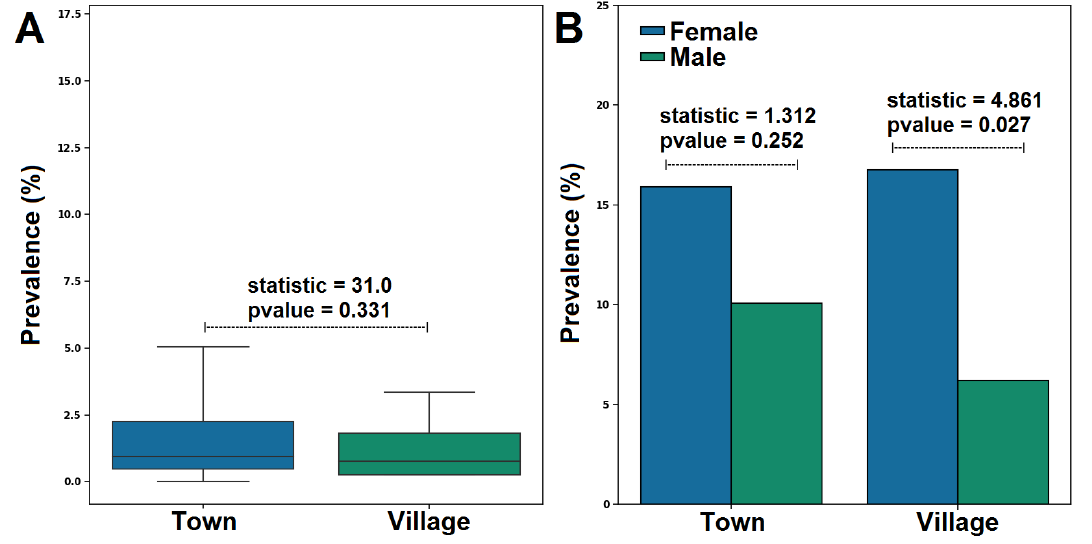
Figure 2. Malaria cases prevalent with site (A) and sex